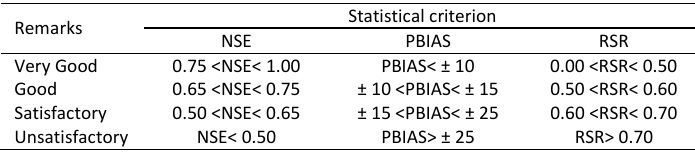
Table 1: Model performance evaluation (Moriasi et al., 2015)